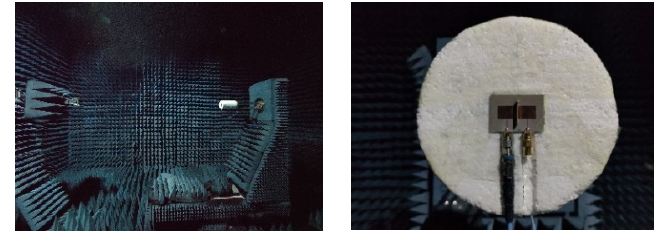
Figure 7. Measurement in the anechoic chamber.